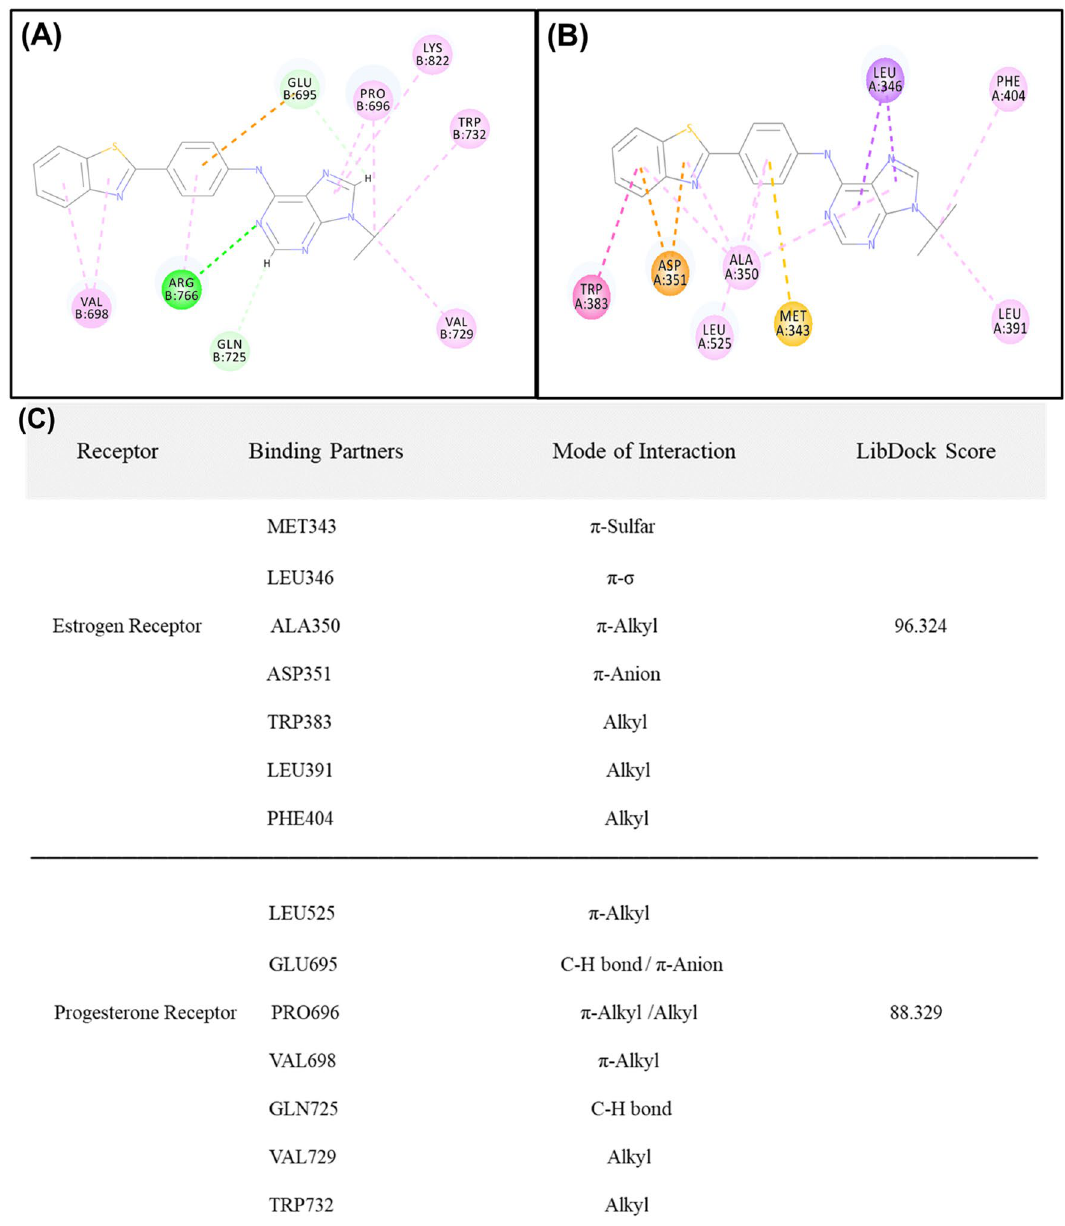
receptor and different amino acid interacting partners. ( C ) Table represents different binding partners and mode of interaction and binding energies of both the receptors with the benzothiazole core structure showing ER to have higher LibDock score than that of